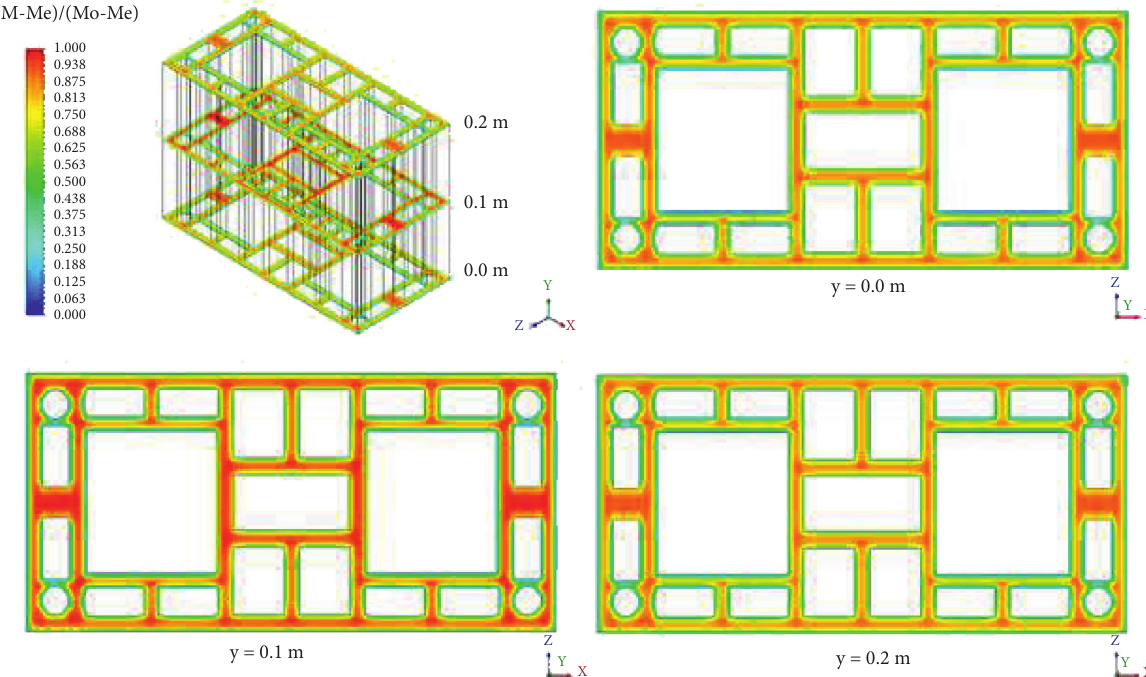
Figure 16: Dimensionless moisture field in the brick, at different planes XZ with the elapsed time of 60 minutes ( T � 80 ° C, RH � 5%). (M-Me)/(Mo-Me)